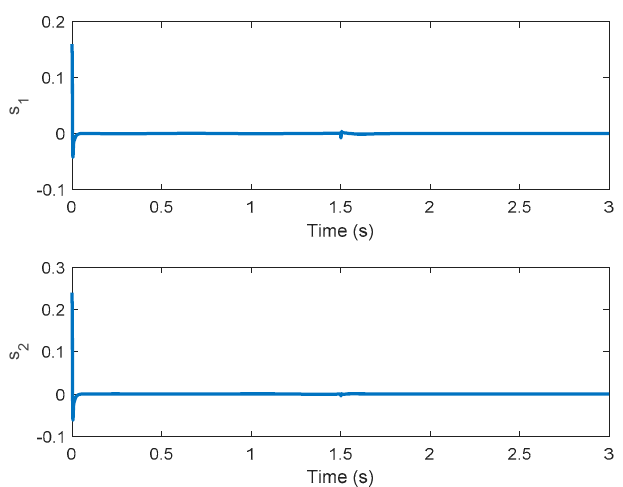
Figure 5. Sliding manifolds for the fixed PID controller with unknown perturbation.